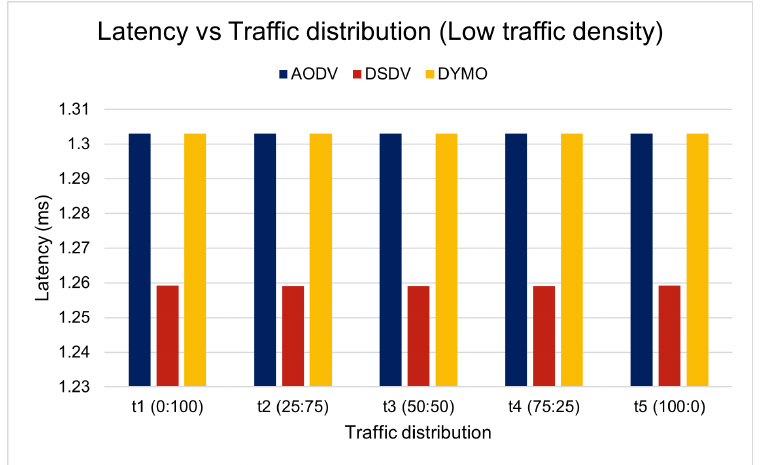
Figure 15. Latency graph for low traffic density with varying traffic distribution.